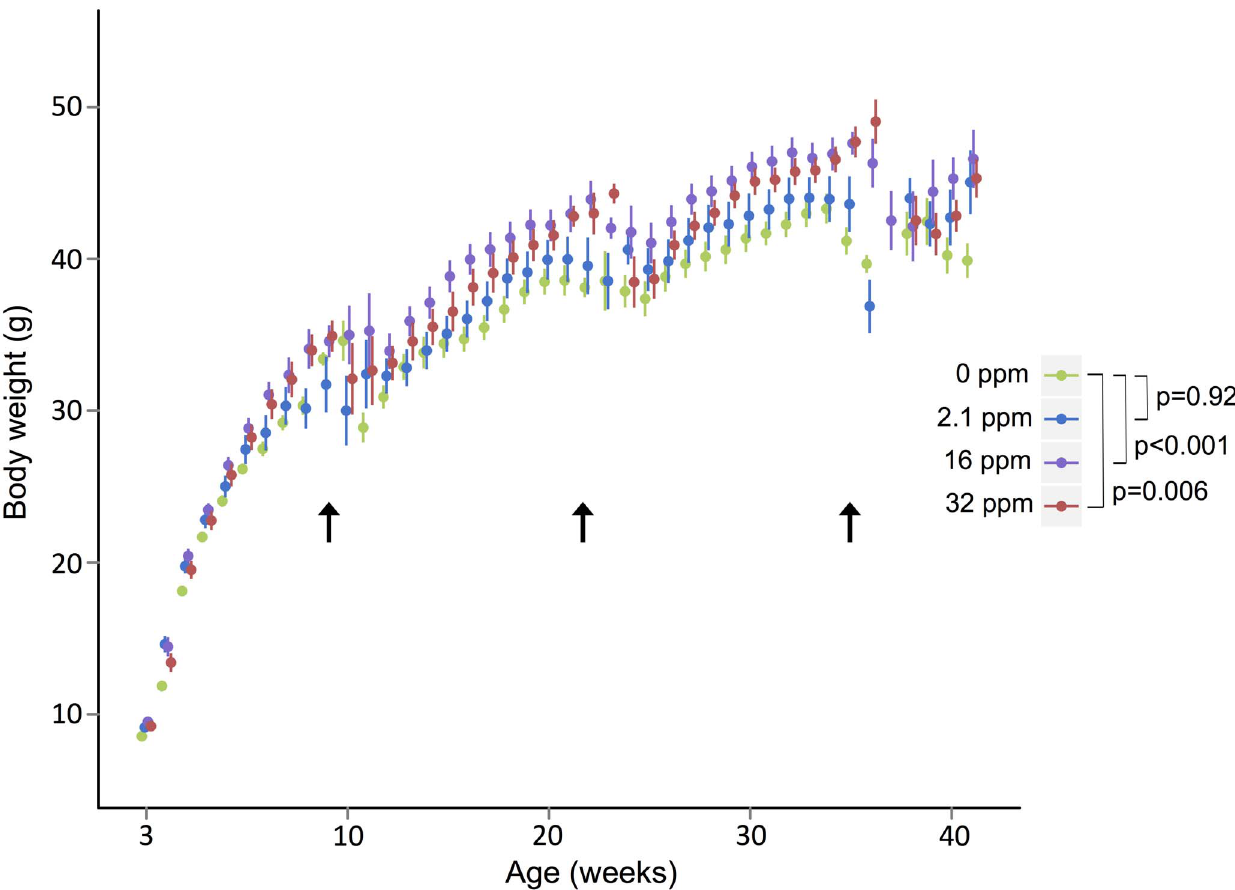
Figure 3. Weekly Body Weight Measurements. Male offspring across all exposure groups (grams) were weighed. Both medium and high exposure groups are significantly increased in weight across the life course as compared to control mice (in green). Arrows indicate weeks when mice were transferred for physiological parameter testing resulting in stress-induced weight loss. Bars represent 95% confidence intervals. P-values were obtained by adjusting for litter, and the autoregressive structure within mice, and adjusting for week using indicator variables for week of measurement.